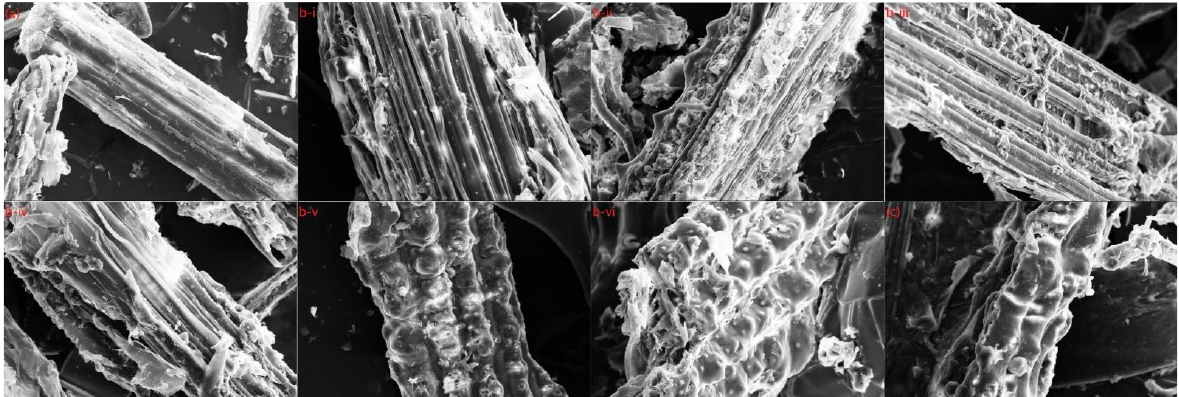
Figure 5. SEM picture of WS: ( a ) unpretreated; ( b ) ( b-i ) (90 °C for 6 h), ( b-ii ) (90 °C for 12 h), ( b-iii ) (120 °C for 6 h), ( b-iv ) (120 °C for 12 h), ( b-v ) (150 °C for 6 h), and ( b-vi ) (150 °C for 12 h); ( c ) 180 ℃ .